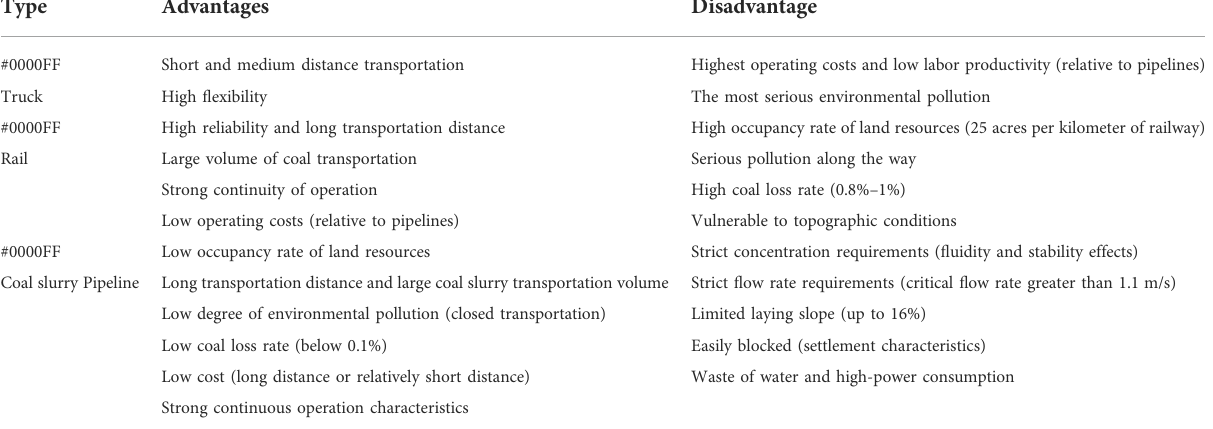
TABLE 1 Comparison of key features of coal transportation